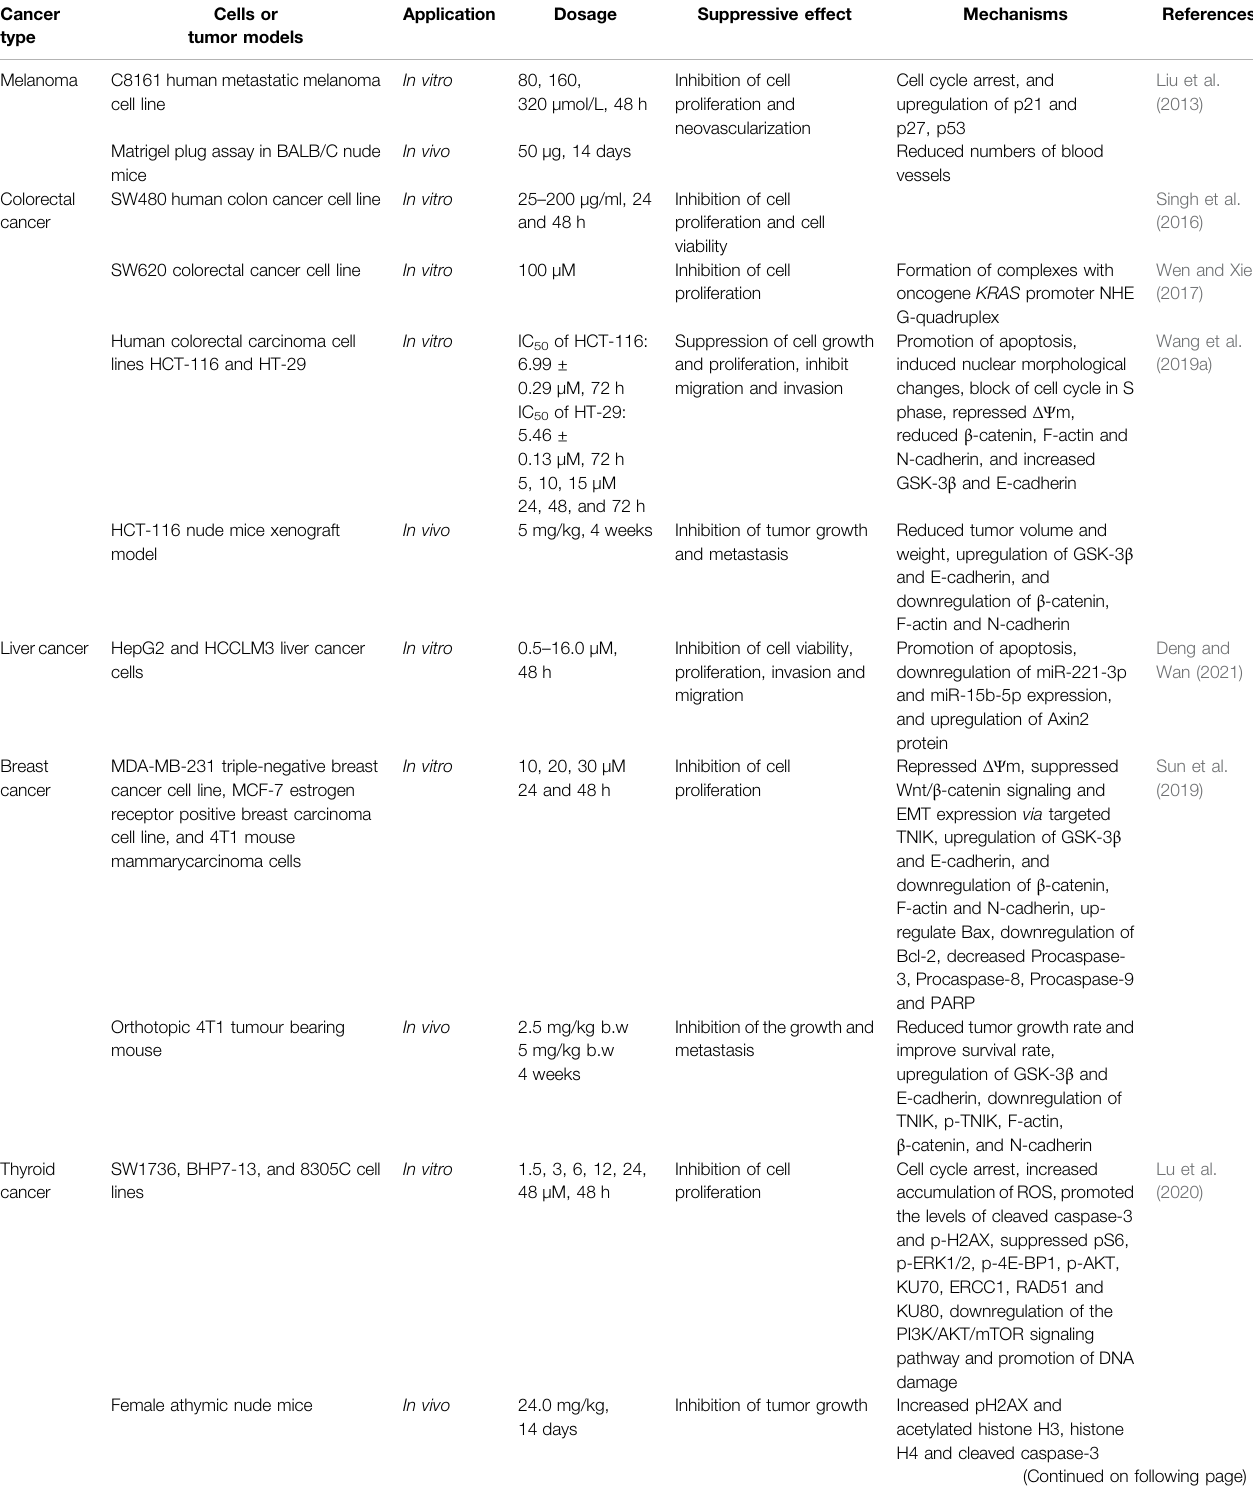
TABLE 3 | The anti-cancer effects of jatrorrhizine and its